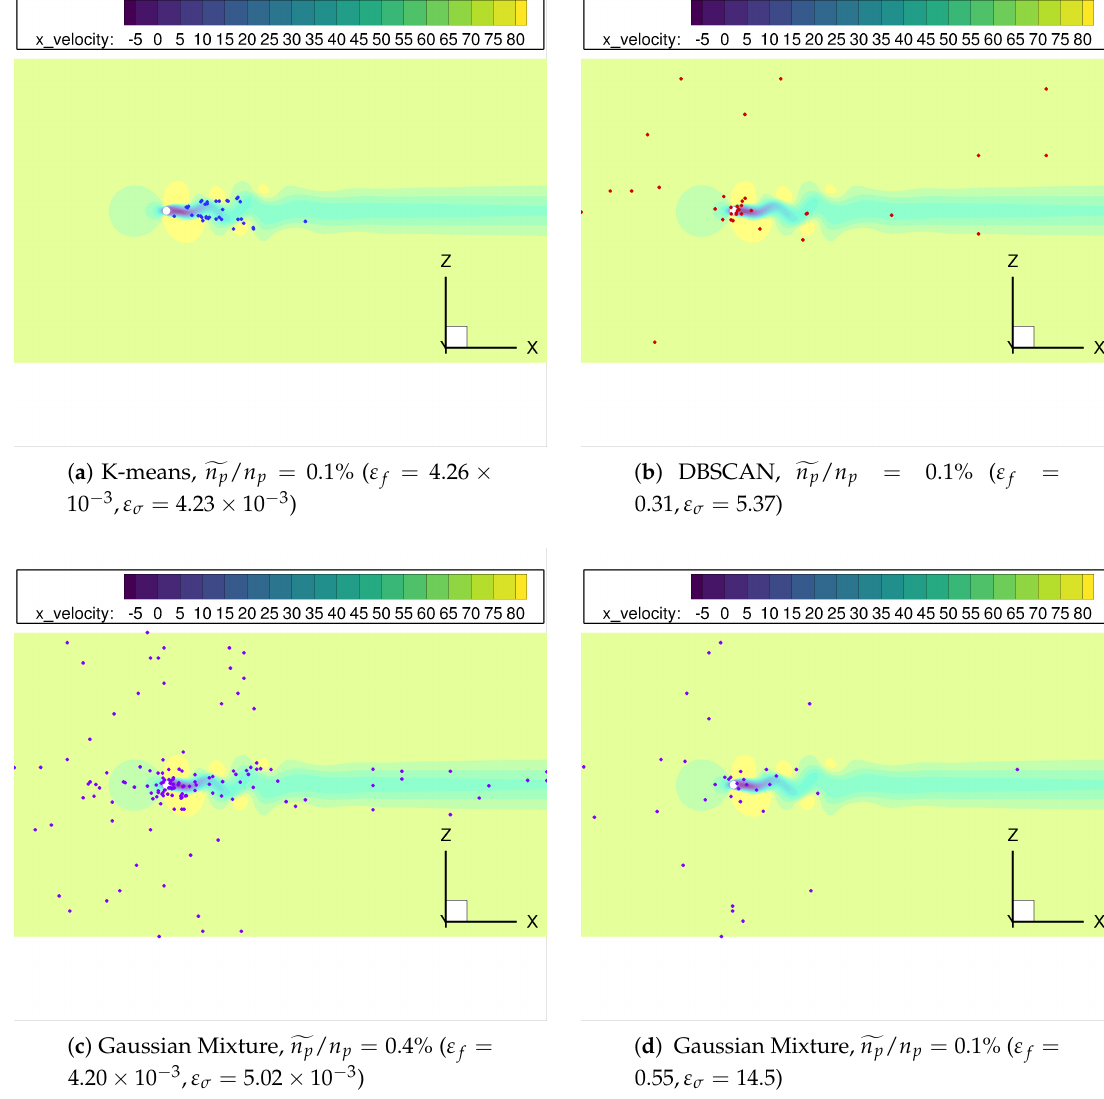
Figure 11. Re D = 60 cylinder flow: The distribution of centroids/cores from different clustering algorithms, with spatial reduction (cid:102) n p / n p <